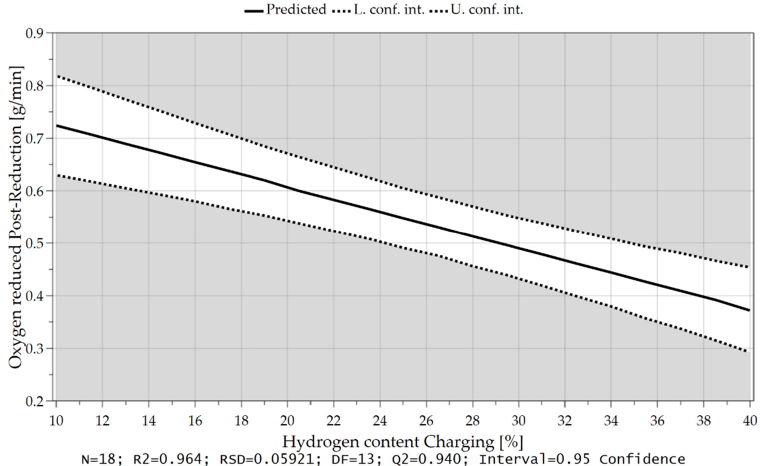
Figure 22. Oxygen removal rate in the post-reduction depending on the hydrogen content during iron ore feeding.